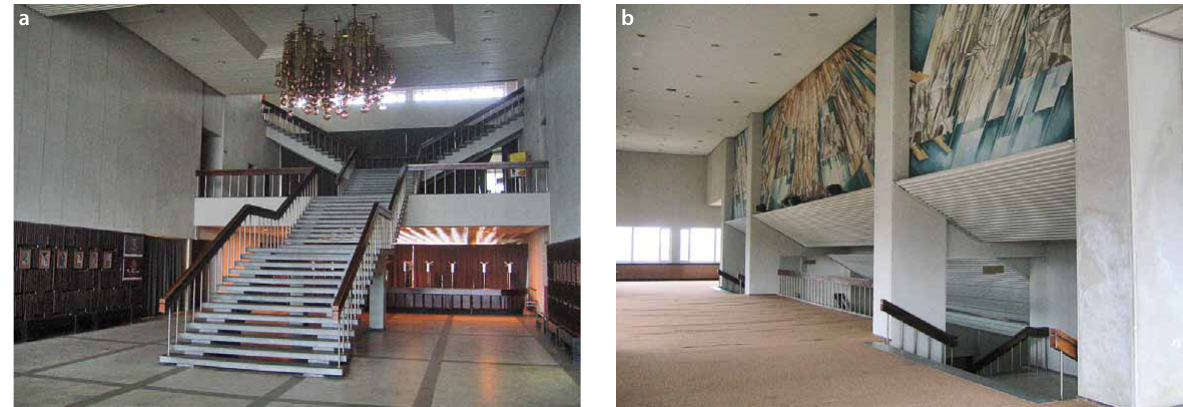
Fig. 8. The Interior of Culture and Sports Palace of Ministry of Domestic affairs with the main stairway (a); The Interior of Culture and Sports Palace of Ministry of Domestic affairs with the mural by K. Stoškus“Culture-Progress-Sport“ (b). a. novickas